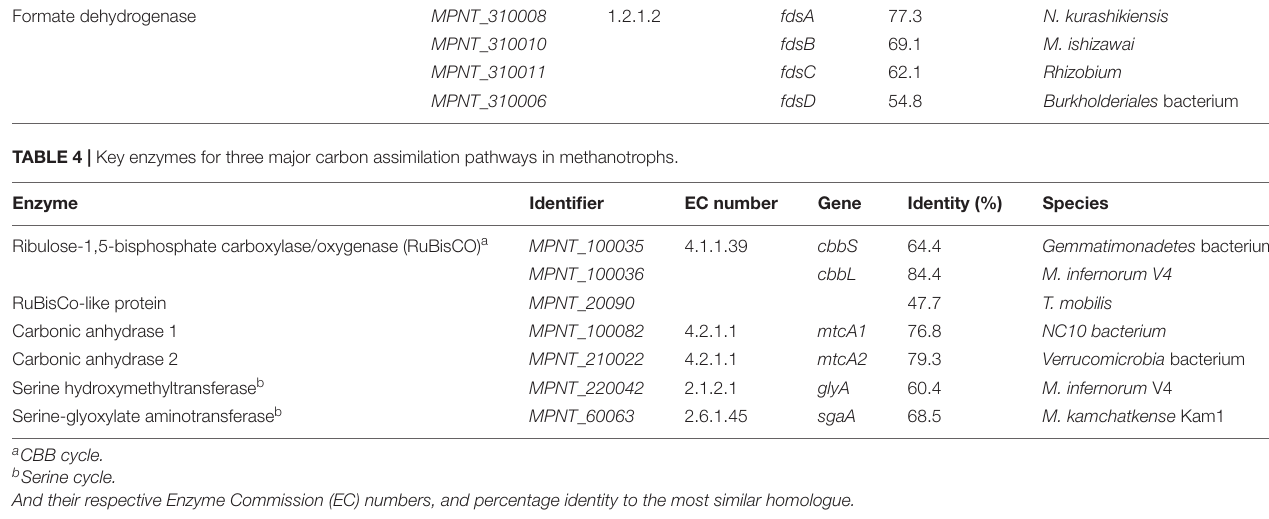
RuBisCo-like protein